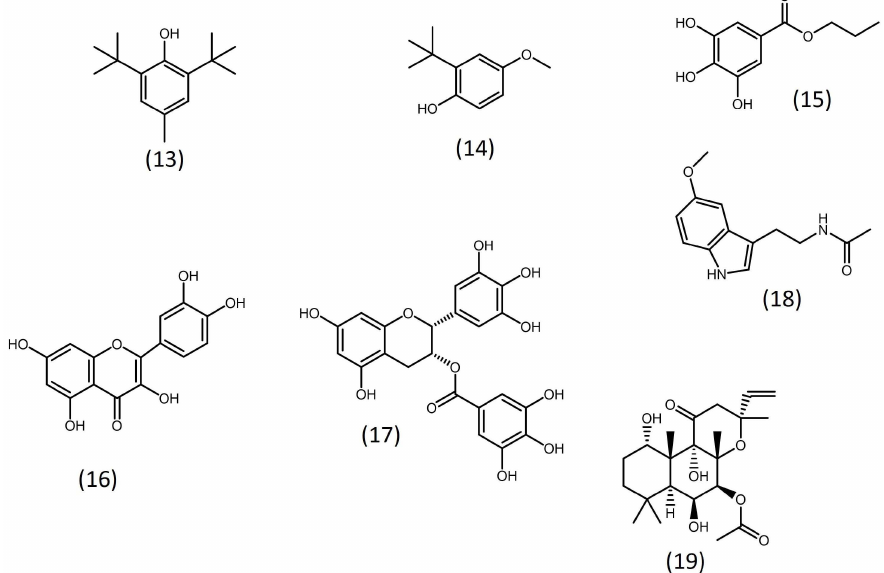
Figure 3. Structure of some chemicals with the potential to increase microalgal lipid productivity. ( 13 ) Butylated hydroxytoluene (BHT); ( 14 ) butylated hydroxyanisole (BHA); ( 15 ) propyl gallate; ( 16 ) quercetin; ( 17 ) (-) epigallocatechin gallate; ( 18 ) melatonin; ( 19 )